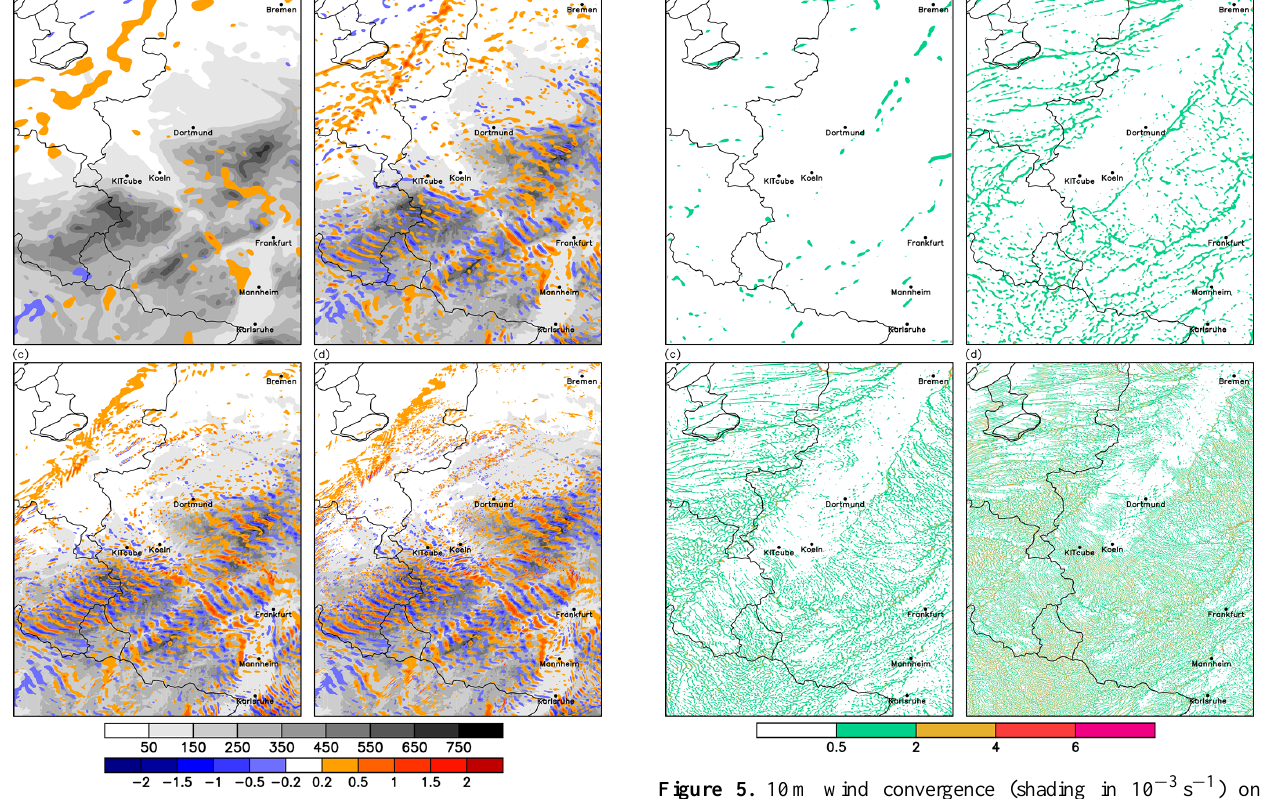
Figure 4. Vertical wind (color shading in ms − 1 at 2900ma.s.l. on 26 April 2013 at 11:30UTC for (a) 2.8km, (b) 1km with 1-D tur- bulence, (c) 500m, and (d) 250m grid spacing. Gray shading rep- resents model orography in m.